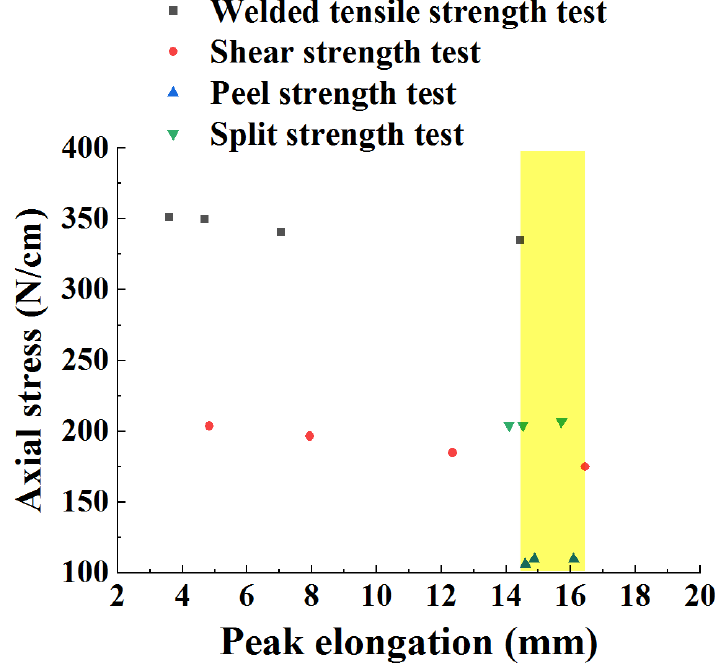
Figure 20. Junction test results under various clamping distances: axial stress versus peak elongation.